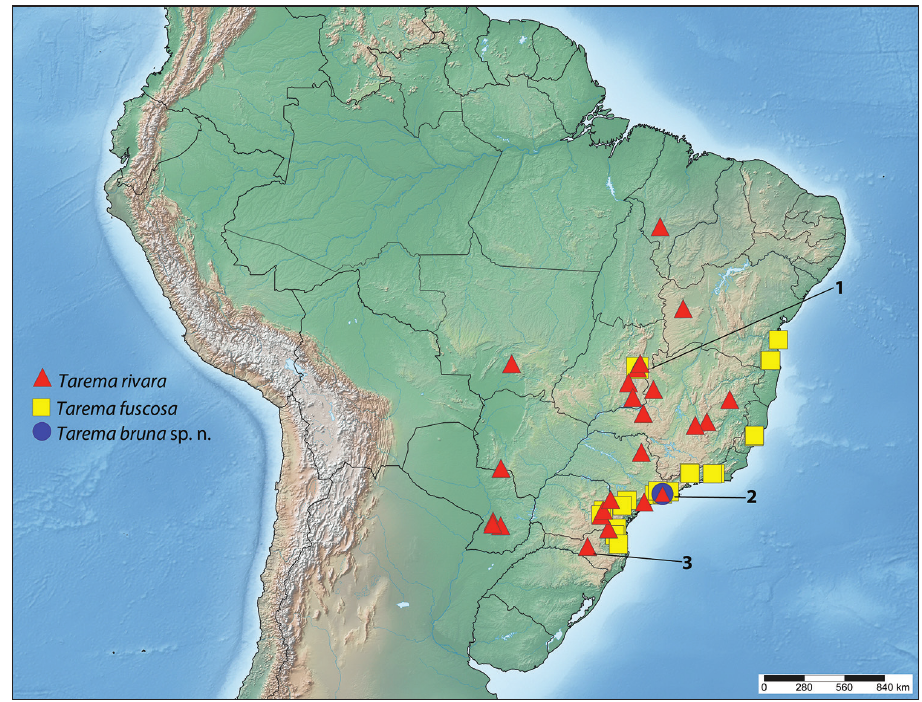
Figure 16. Known distribution of Tarema . Numbers superimposed on the map refer to the following annotations: 1 Outlier data point for T. fuscosa in Brazil, Distrito Federal may be erroneous (see remarks for that species). 2 The point where all three symbols are found on top of each other is a single locality, that being Brazil, São Paulo, Paranapiacaba. 3 Data point for T. rivara in Brazil, Santa Catarina is placed at the center of the state because no detailed locality data is available for this species from Santa